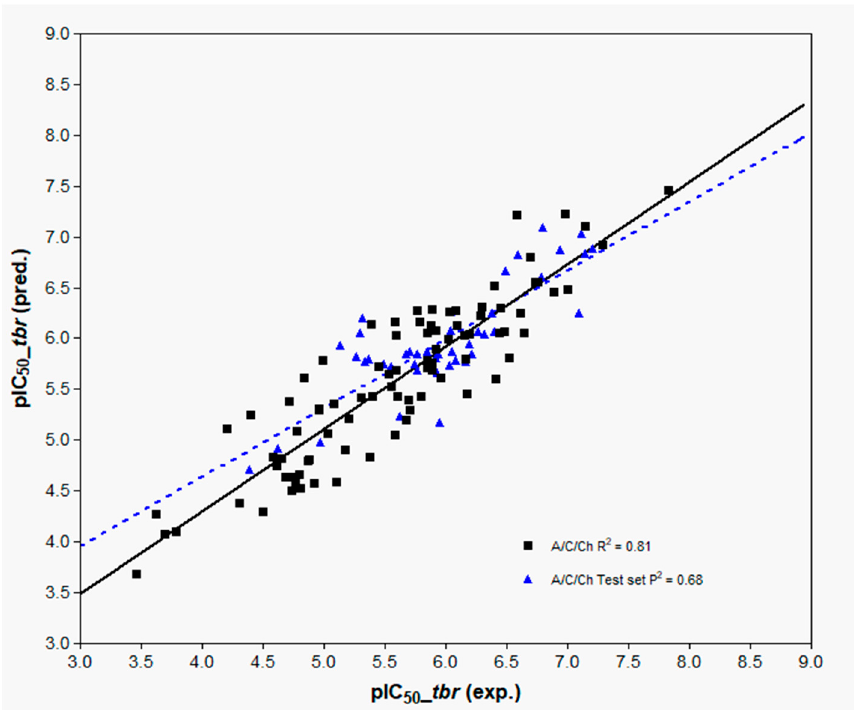
Figure 7. Experimental versus predicted pIC 50 values of training and test sets of the A/C/Ch HQSAR model (Model 8).